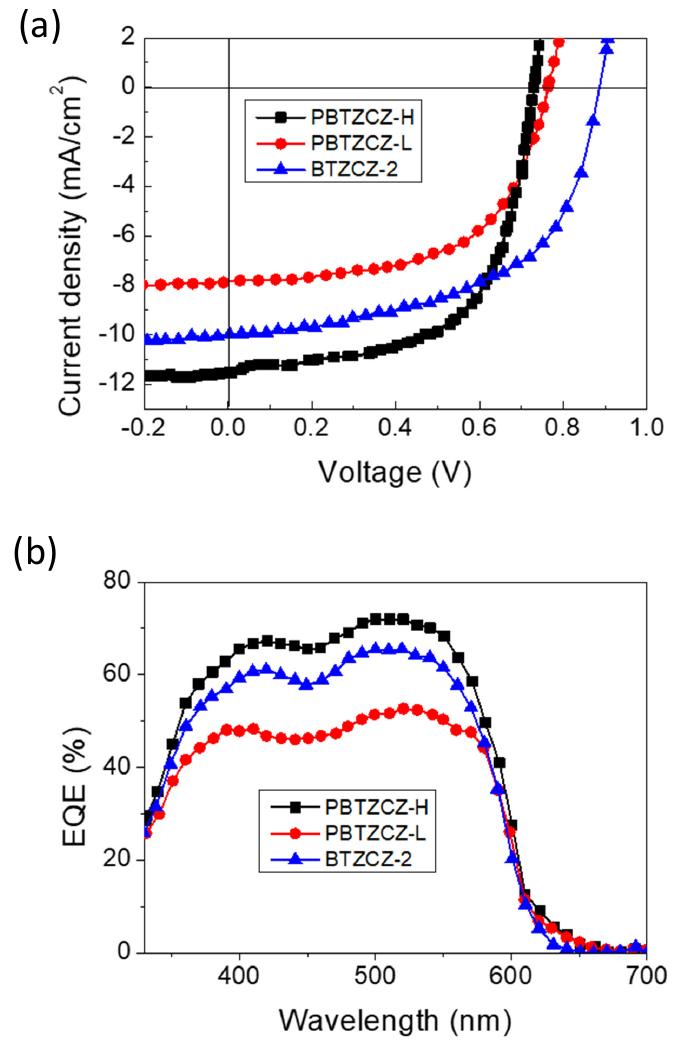
Figure 5. ( a ) J-V characteristics and ( b ) External quantum efficiency characteristics of the BTZCZ-2 -, PBTZCZ-L -, and PBTZCZ-H -based inverted OPV devices.